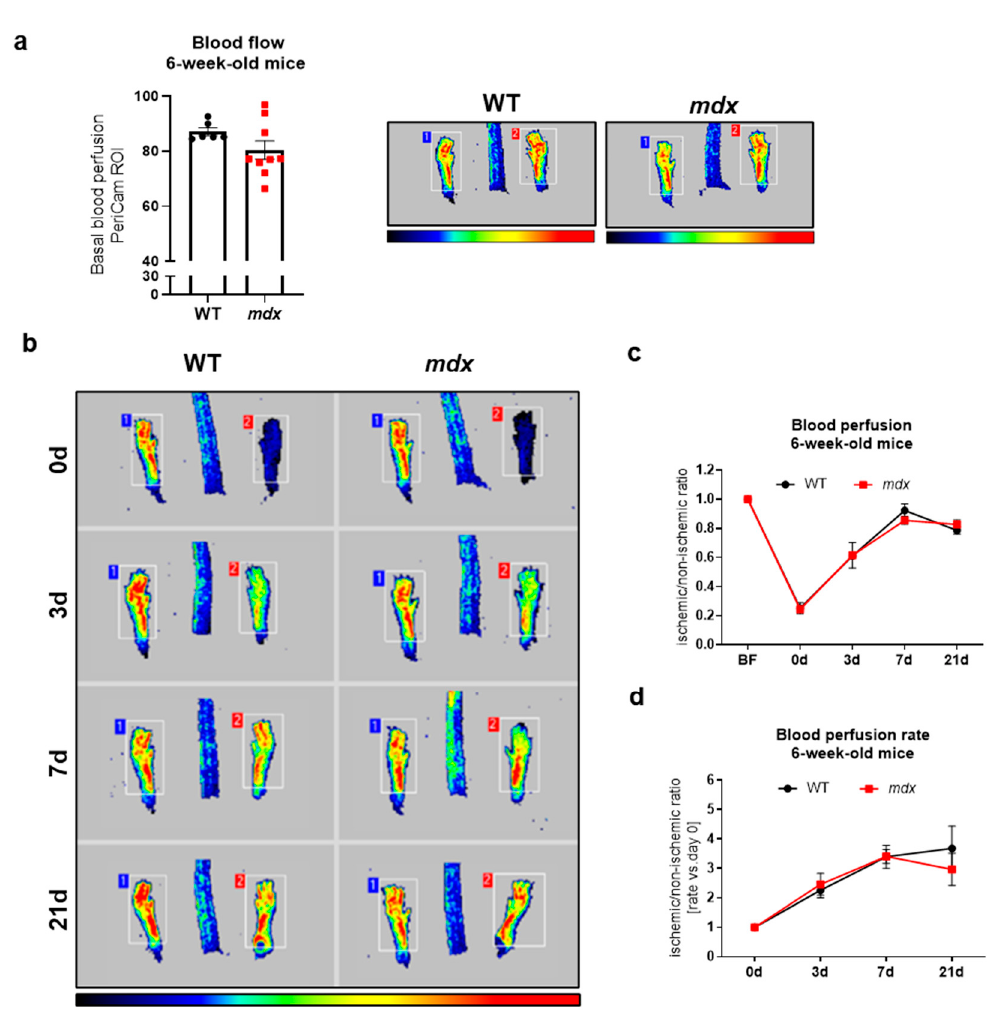
Figure 4. Basal blood flow and revascularization in 6-week-old WT and mdx animals following hindlimb ischemia (HLI). ( a ) Hindlimb blood flow of 6-week-old wild-type and dystrophic animals; PeriCam measurement; region of interest (ROI); n = 6–9/group. ( b ) The recovery of blood flow in WT and mdx mice in the following days after the HLI procedure shown by representative pictures and ( c ) calculation of blood perfusion and ( d ) blood perfusion recovery rate; n = 5–10/group. The results are presented as mean ± SEM. The statistical significance was tested with ( a ) unpaired two-tailed Student’s t -test or ( c , d ) two-way ANOVA with Tukey’s posthoc test.